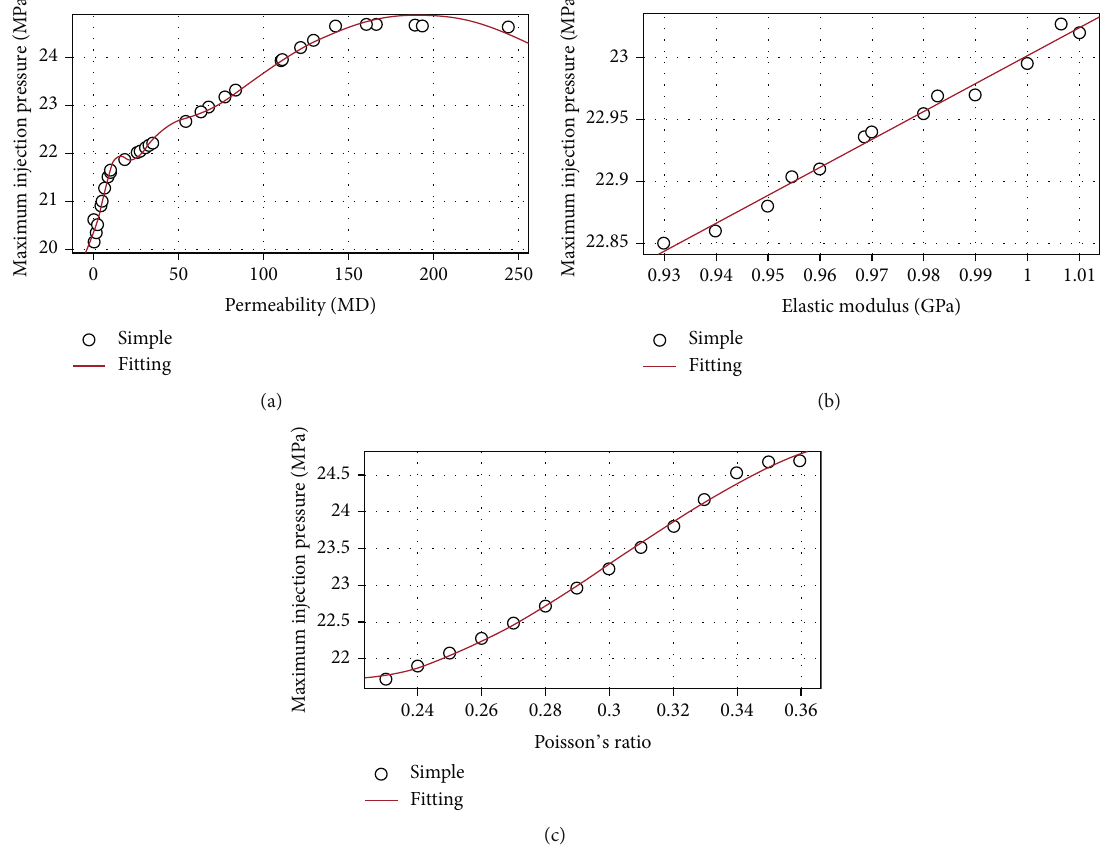
Figure 10: Curves of maximum injection pressure versus K , E , and μ